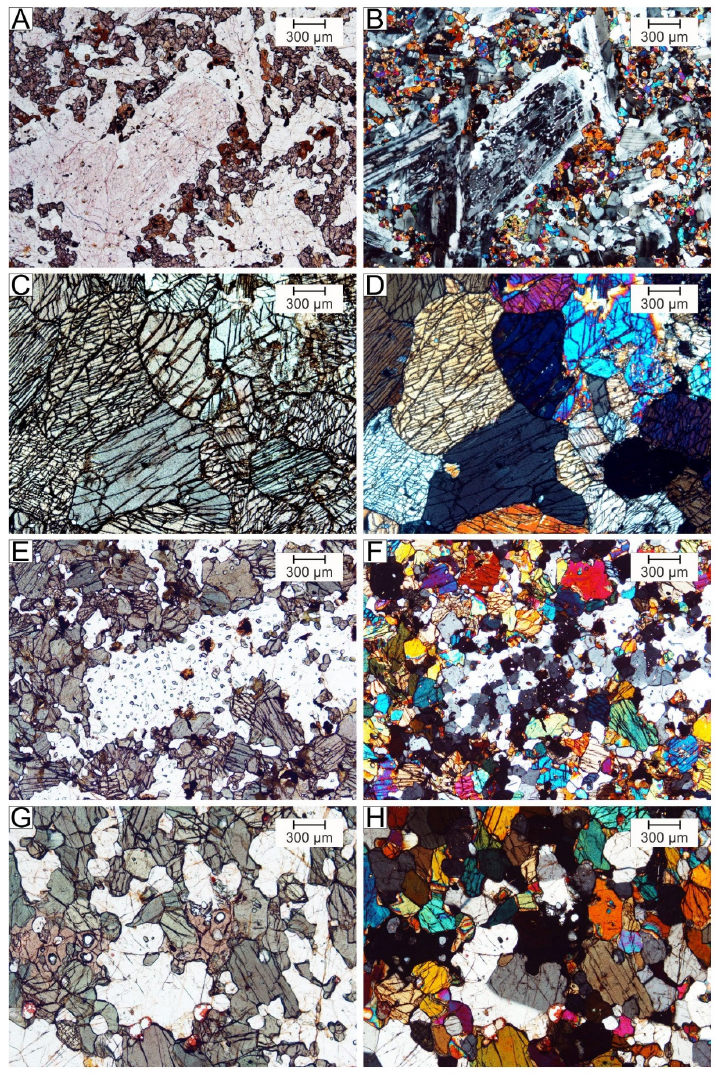
Figure 7. Photomicrographs of dolerite and related rocks (thin sections). ( A , B ) dolerite; ( C , D ) monomineral pyroxenite with large plagioclase laths replaced by nepheline in the center and fine-grained aggregates of clinopyroxene (purple), pargasite and biotite (brown); ( E , F ) nepheline-fassaite rock with nepheline pseudomorphs after plagioclase; ( G , H ) skarned pyroxenite with fassaite (brownish-tobacco green), nepheline (white), and garnet (brownish-orange). ( A , C , E , G ) plane-polarized light; ( B , D , F , H ) cross polarized light.